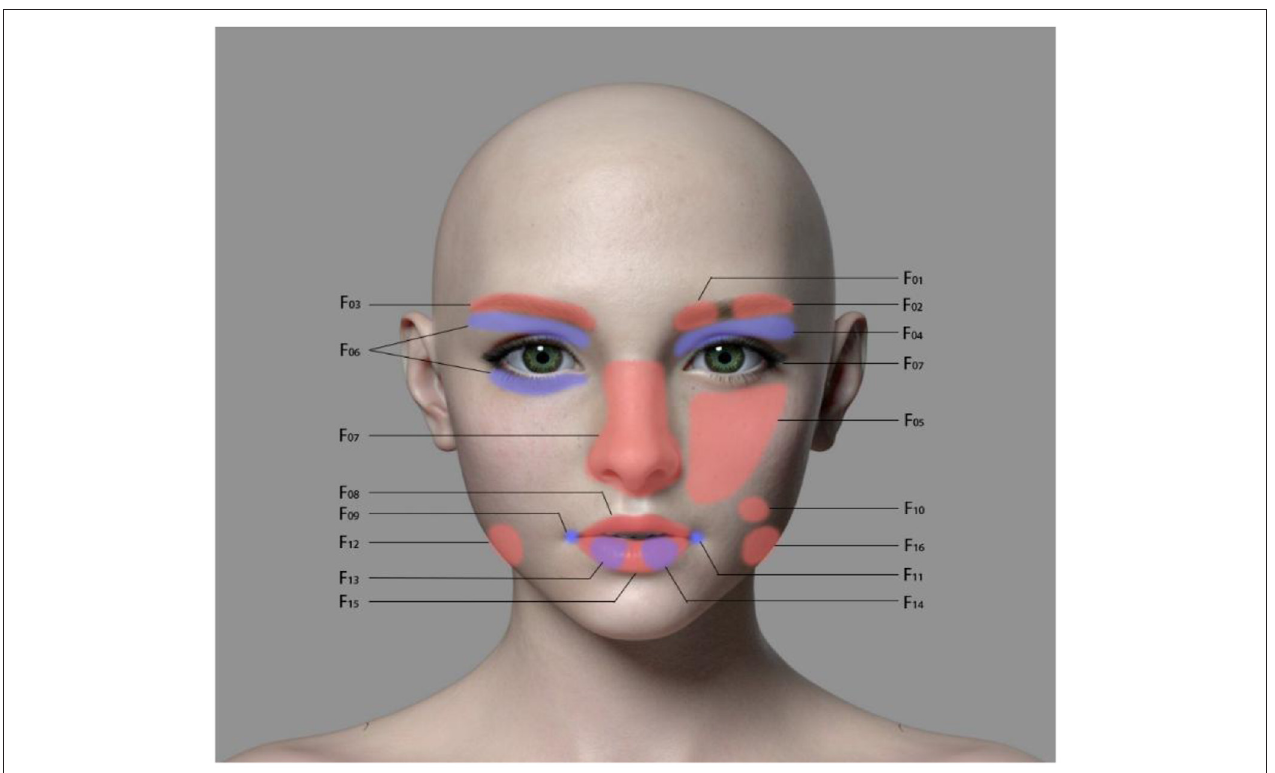
FIGURE 1 | The 17 sites of facial muscle activity intensity measurement in this study.